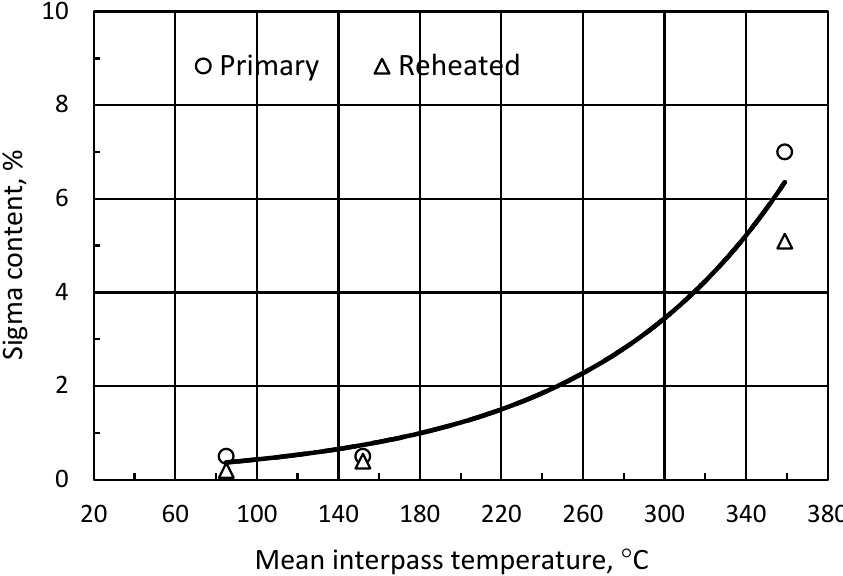
Figure 11. Sigma phase content as a function of mean interpass temperature. The black curve is an exponential fit.